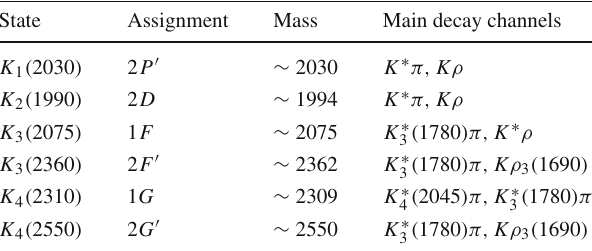
Table 17 The mass and the important strong decay channels for some predicted kaon states which can be helpful in future search for them in experiments. The units of the mass and width are